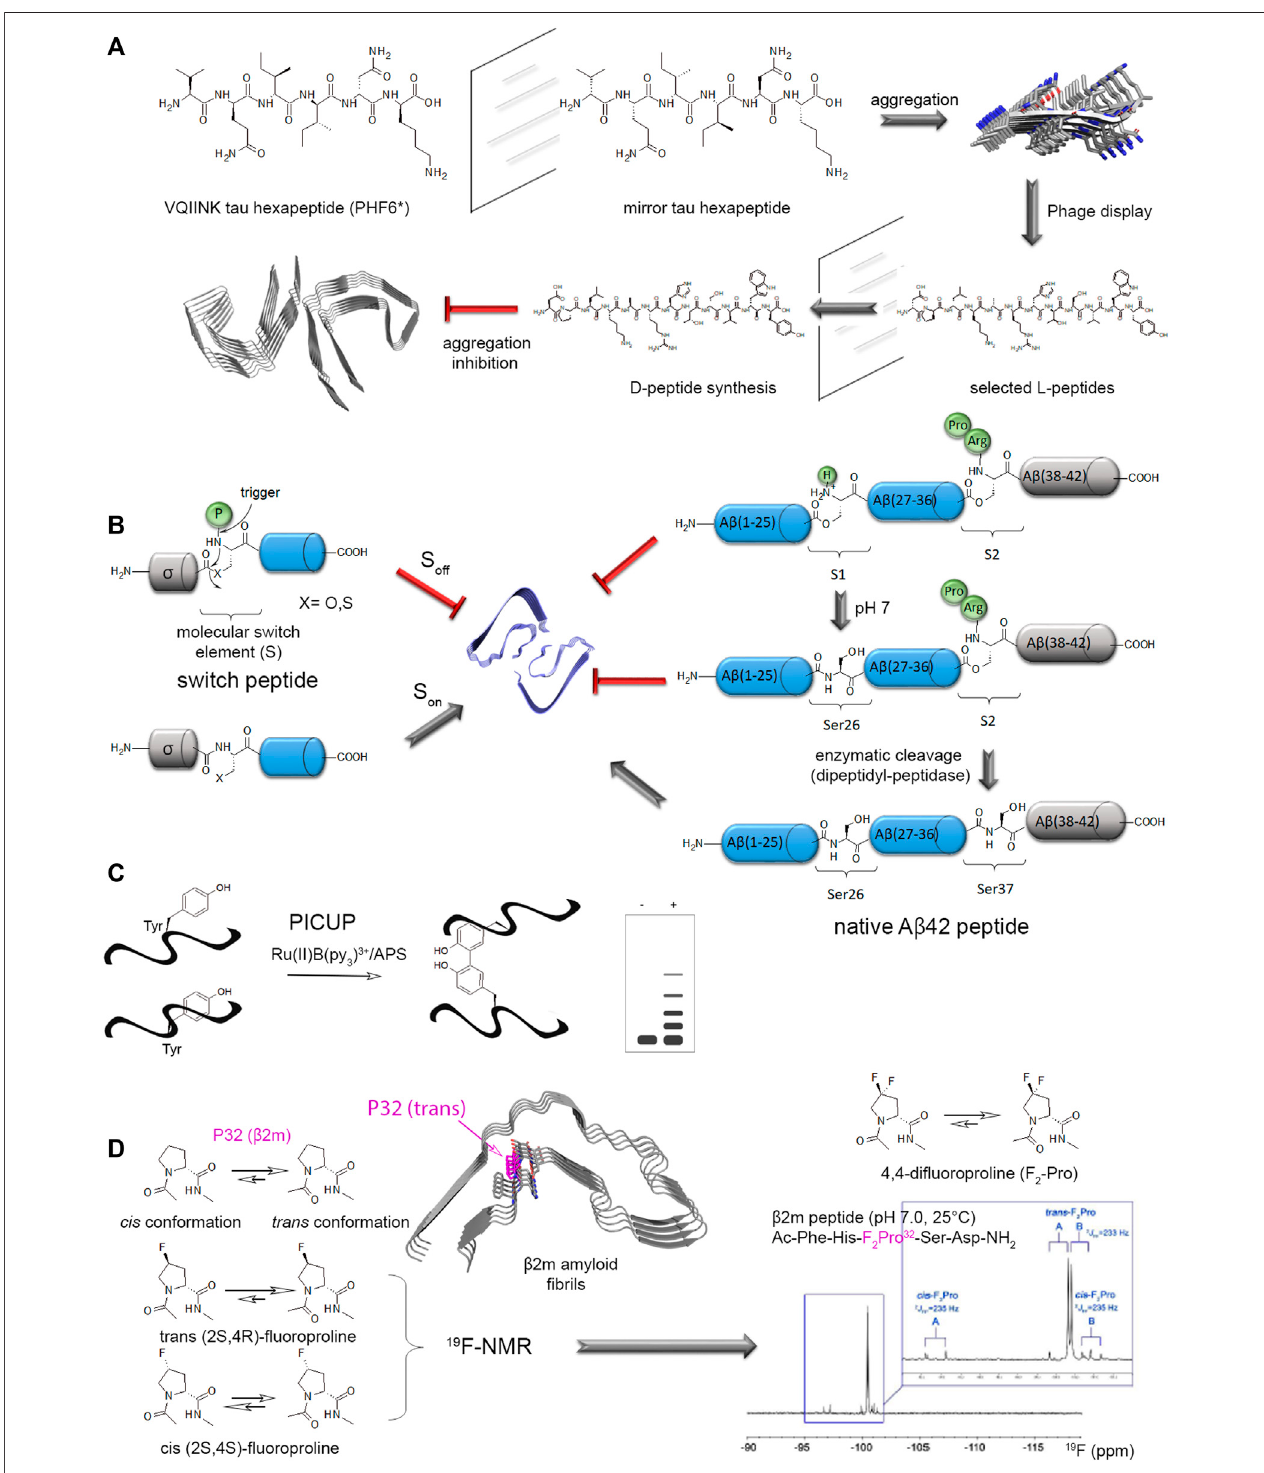
FIGURE 11 | Chemical biology tools for controlling and deciphering the amyloid aggregation pathways. (A) Fibrils made of the mirror PHF6* hexapeptide of tau consisting of D-enantiomeric amino acids was used in mirror image phage display to screen L-peptides that bind to mirror PHF6* fi brils. The mirror peptides of the selected L-peptides were synthesized and evaluated as inhibitors of full-length tau aggregation exhibiting protease stability and reduced immunogenicity (Dammers etal.,2016;Malhisetal.,2021). (B) Thestrategyof “ click ” peptidesor “ switch ” peptidesisusedtocontrolproteinaggregationanddecipherthemolecularelements responsibleofamyloidaggregation(leftpanel).Amolecularswitchelement(S)isundercontrolofaprotectinggroup “ P ” (greendots)thatpreventaggregation(S off )andis